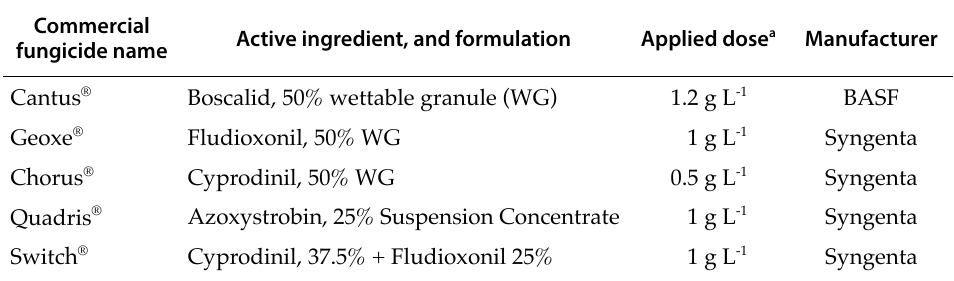
Table 1. Fungicides used in this study, their active ingredients, formulations, applied doses and